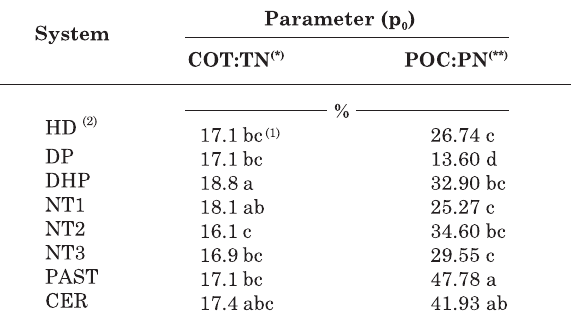
Table 5. Comparison of the regression variable p